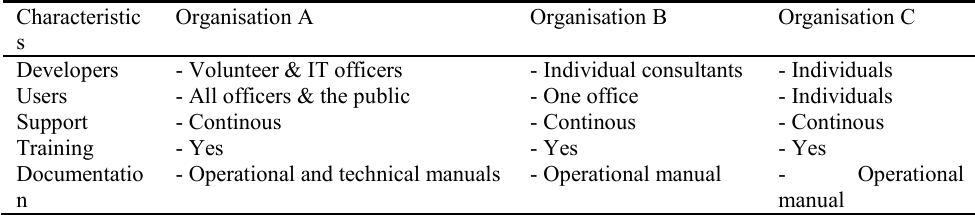
Table 3. Human dimension in three